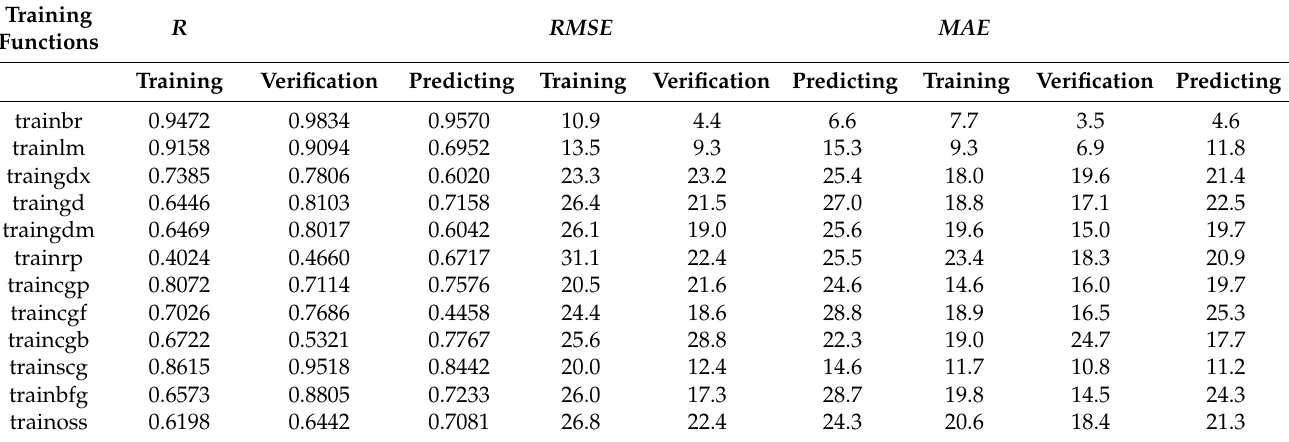
Table 5. Comparison of R , RMSE ( µ g/m 3 ), and MAE ( µ g/m 3 ) between various training algorithms.